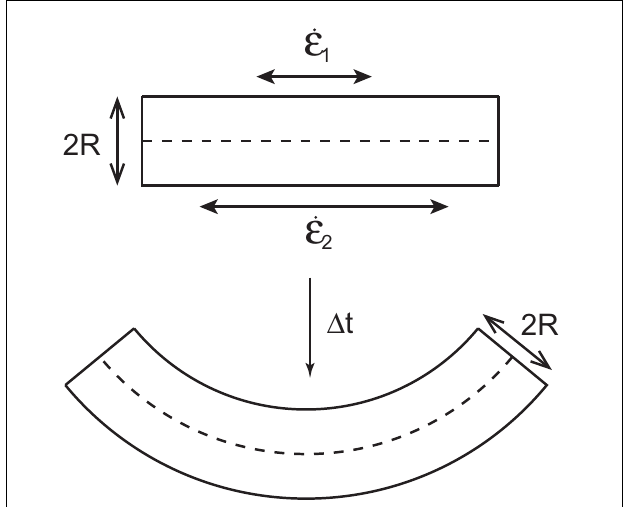
FIGURE 2 | A small element of an organ is considered as a cylinder of radius R with the upper side of length δ s 1 and the lower side of length δ s 2 . The sides are growing with a relative elongation rates of ˙ (cid:5) 1 and ˙ (cid:5) 2 , respectively. After time t the curvature of the organ has